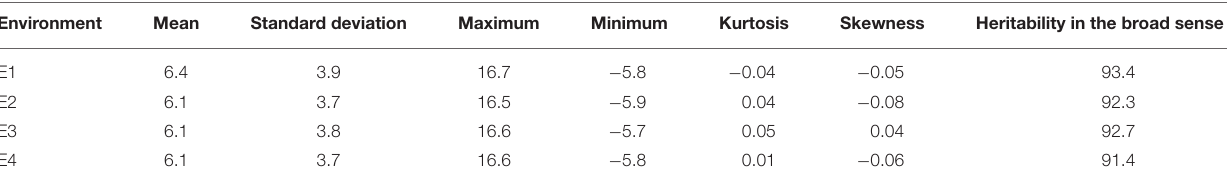
TABLE 3 | Phenotypic characteristics of the PEL (cm) based on 540 rice accessions in natural population across four environments. Environment